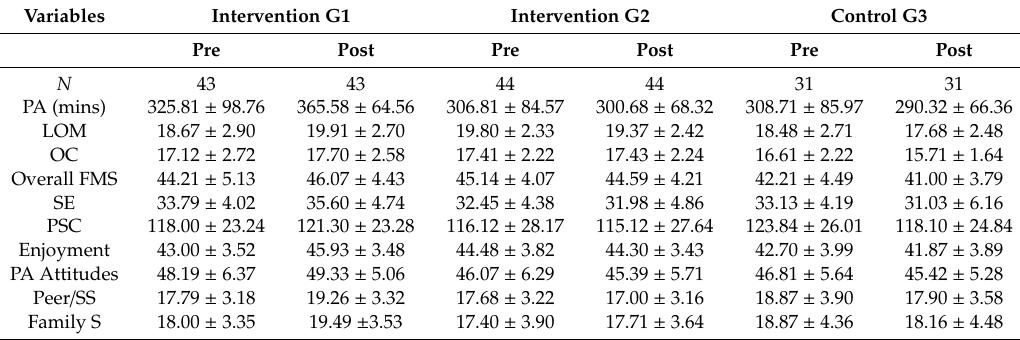
Table 2. Descriptive statistics [means and standard deviations (M ± SD)] of PA, FMS and psychological measurements, stratified by group and